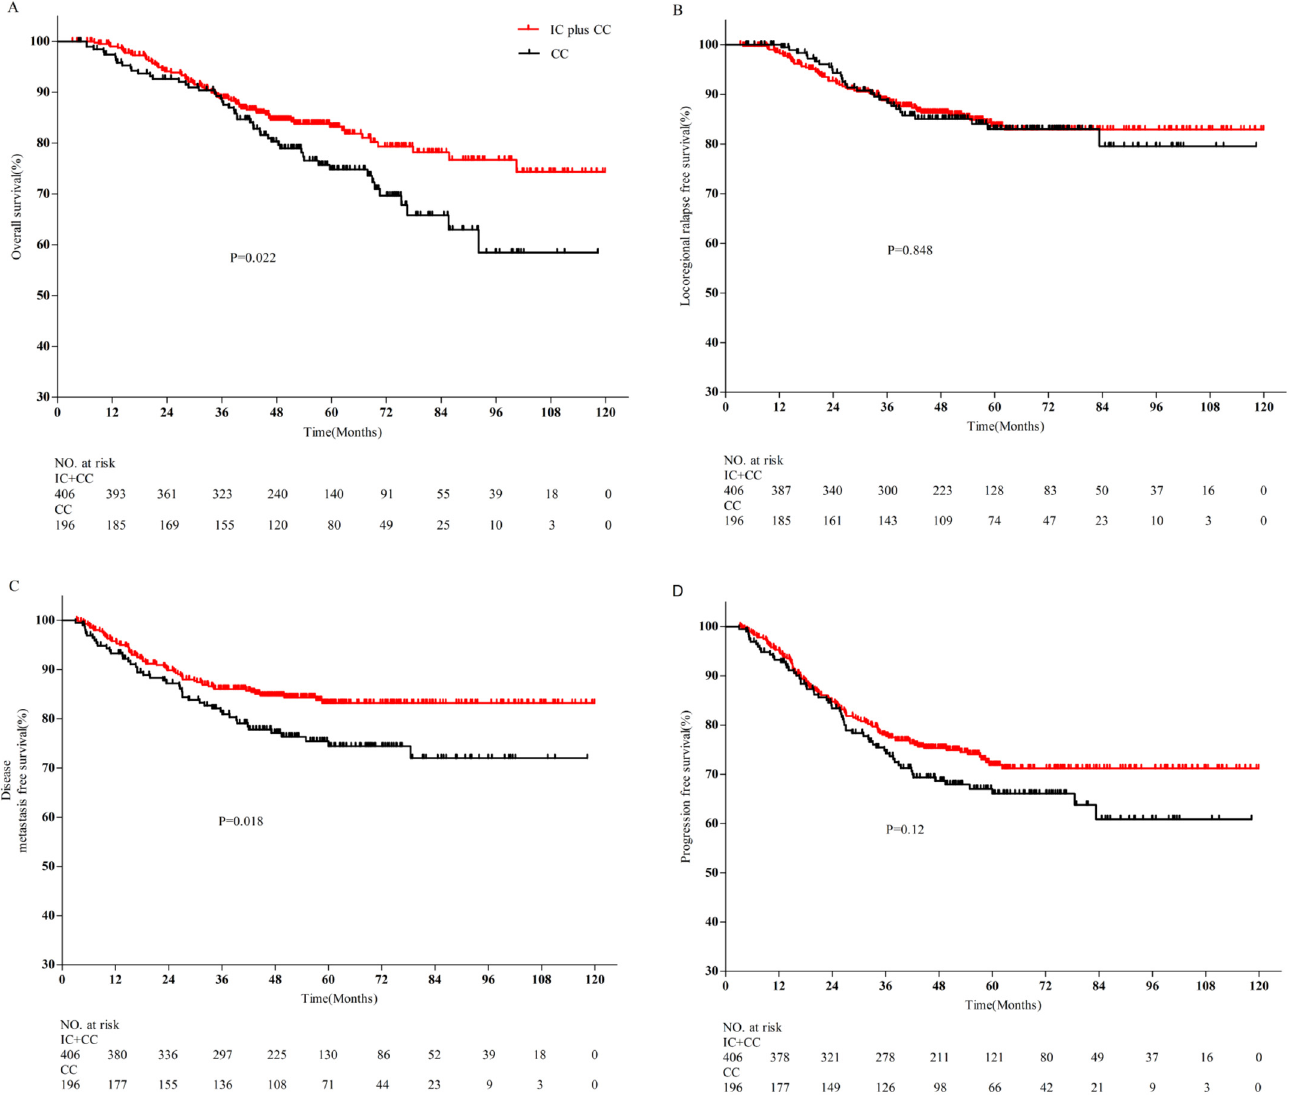
Fig 1. Kaplan-Meier survival curves for induction chemotherapy plus concurrent chemotherapy and concurrent chemotherapy alone in the 602 patients with stage IVa-b nasopharyngeal carcinoma treated with IMRT. (A) Overall survival; (B) locoregional relapse-free survival; (C) distant metastasis-free survival; (D) progression-free survival. Abbreviations: IMRT = intensity-modulated radiotherapy; IC = induction chemotherapy; CC = concurrent chemotherapy. P -values were calculated using the unadjusted log-rank test.